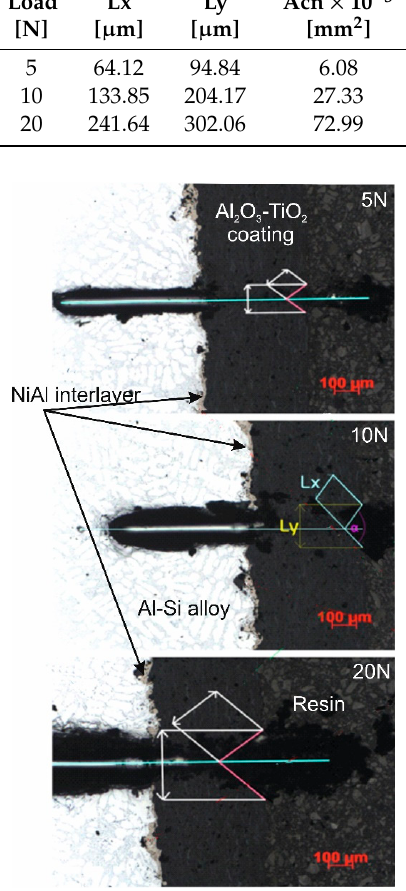
Figure 11. Cone-shaped crack occurring during the scratch bond test for the Al 2 O 3 -15 wt.%TiO 2 /NiAl/Al-Si coating system at scratch load of 5, 10, and 20 N.